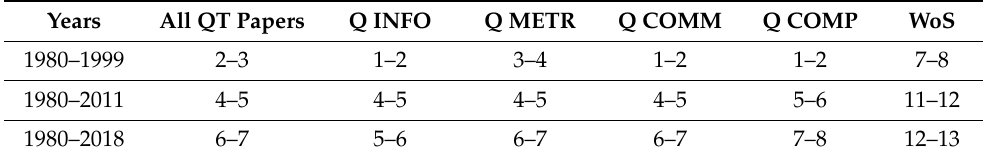
Table 2. Doubling times in years for all QT 2.0 papers and four fields for the years 1980–1999,